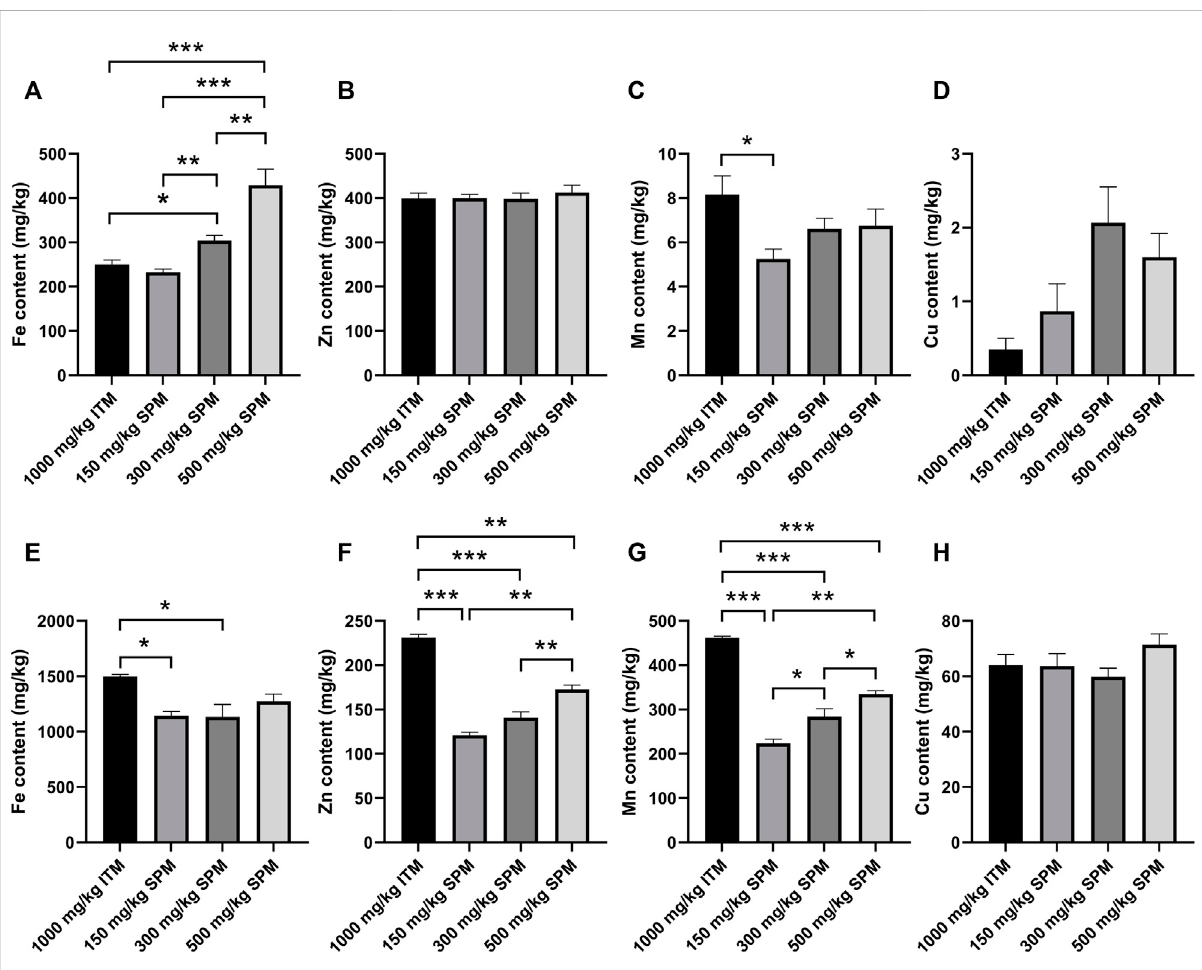
FIGURE 1 Effect of supplementation of ITM and SPM in basal rations on tibial mineral deposition and fecal mineral excretion of chickens. The deposition concentrations of iron, zinc, manganese, and copper in tibial ash were (A – D) , respectively. The fecal excretion concentrations of iron, zinc, manganese, and copper were (E – H) , respectively. Asterisks indicate statistically signi fi cant differences. * indicates p < 0.05; ** indicates p < 0.01; *** indicates p < 0.0001. Data are expressed with mean ±